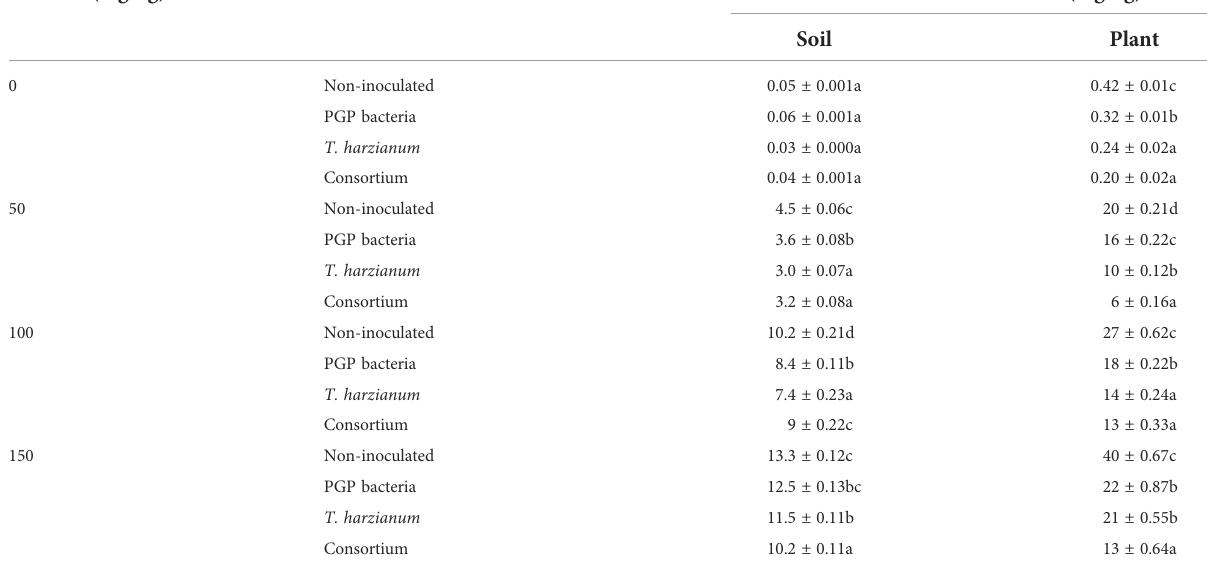
TABLE 6 Cadmium concentrations in soil and sun fl ower plants inoculated and non-inoculated with PGP bacteria, T. harzianum , and Consortium after being affected by different doses of Cd (0, 50, 100, and 150 mg/kg of soil). Cd dose (mg/kg) Inoculation with